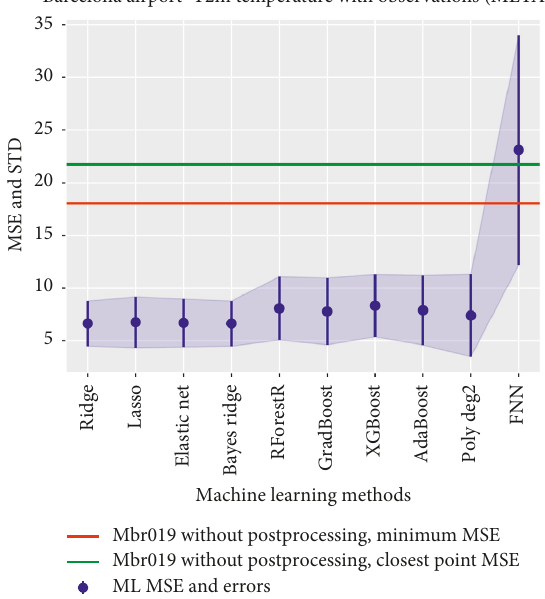
Figure 4: T2m calibration plot for Barcelona airport. Horizontal axis as in Figure